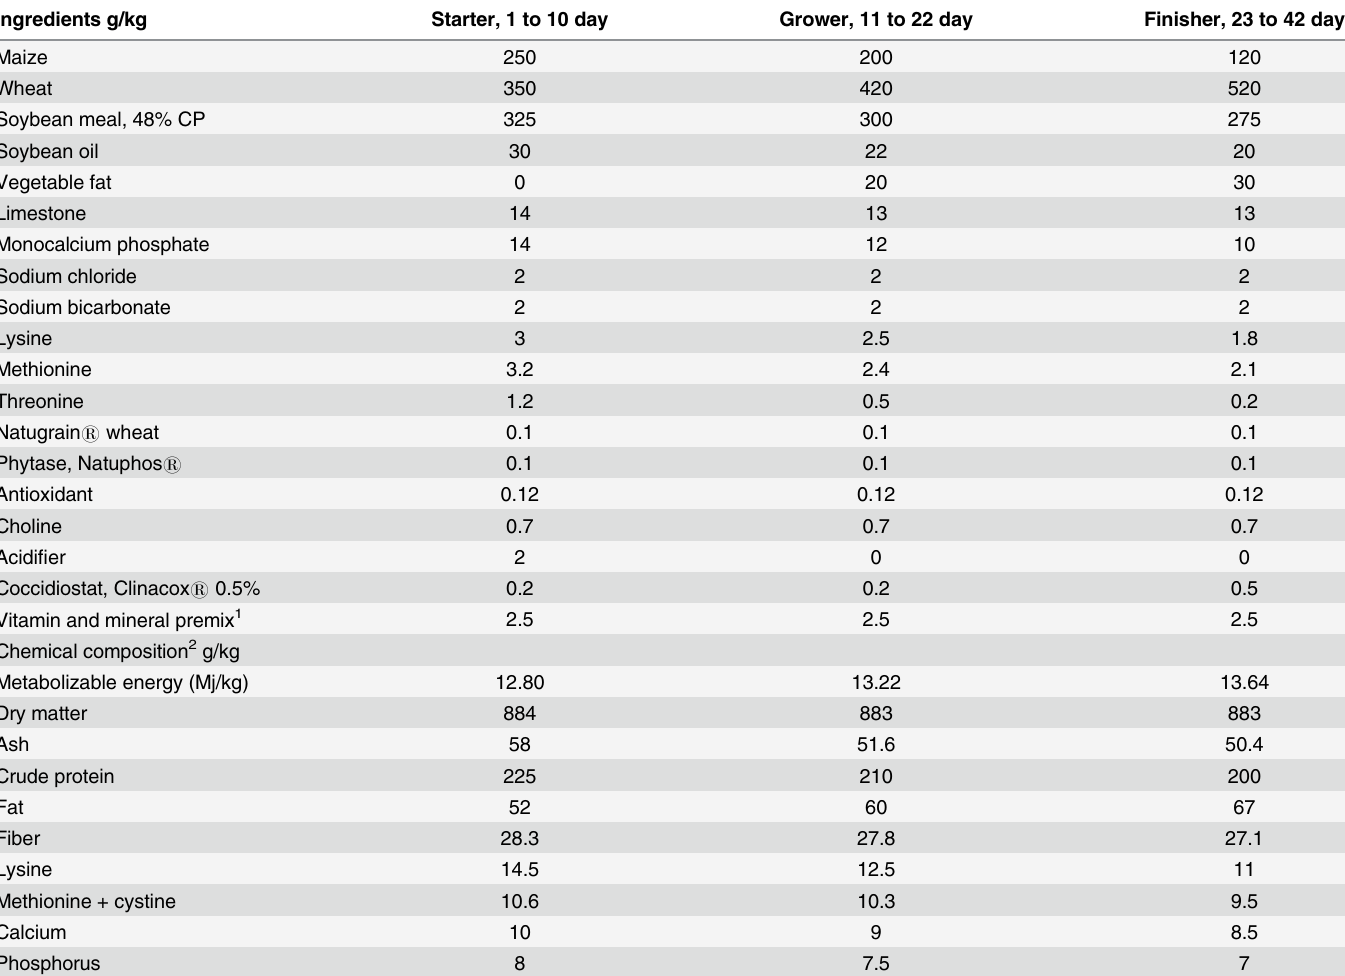
Table 1. Ingredients and chemical composition of the diets